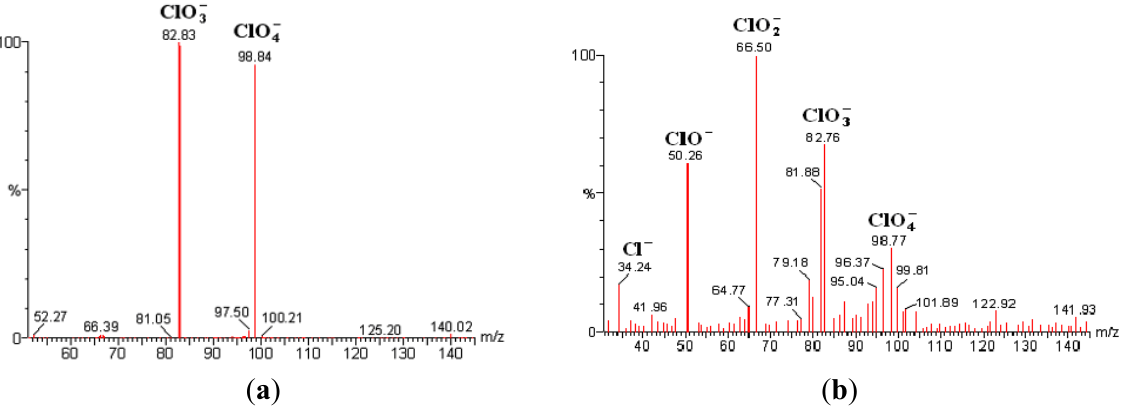
Figure 3. Mass spectra of 1 mg/L stock perchlorate in high performance liquid chromatography (HPLC) eluent acquired with a collision energy of 20 eV ( a ) and 40 eV ( b ).